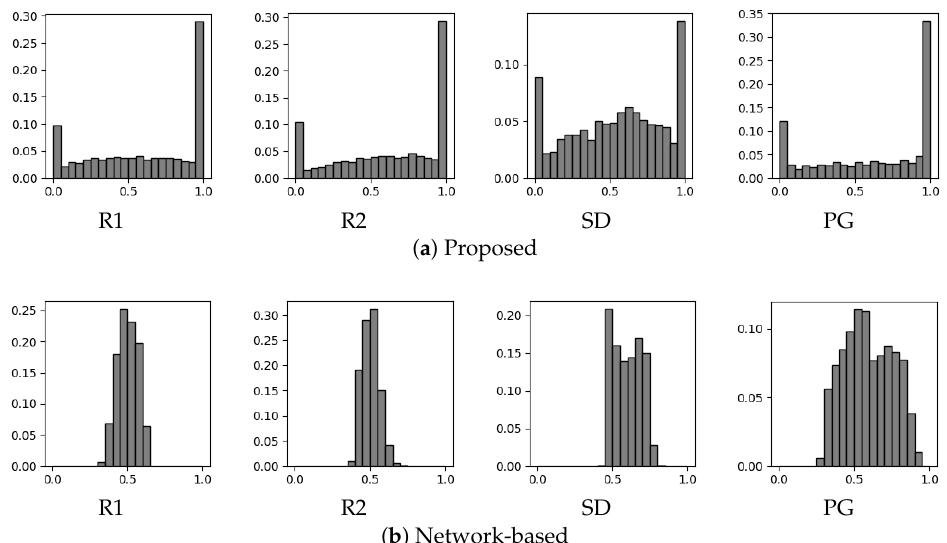
Figure 8. Topic distributions of users. Users are more clearly distinguished into two groups in the proposed